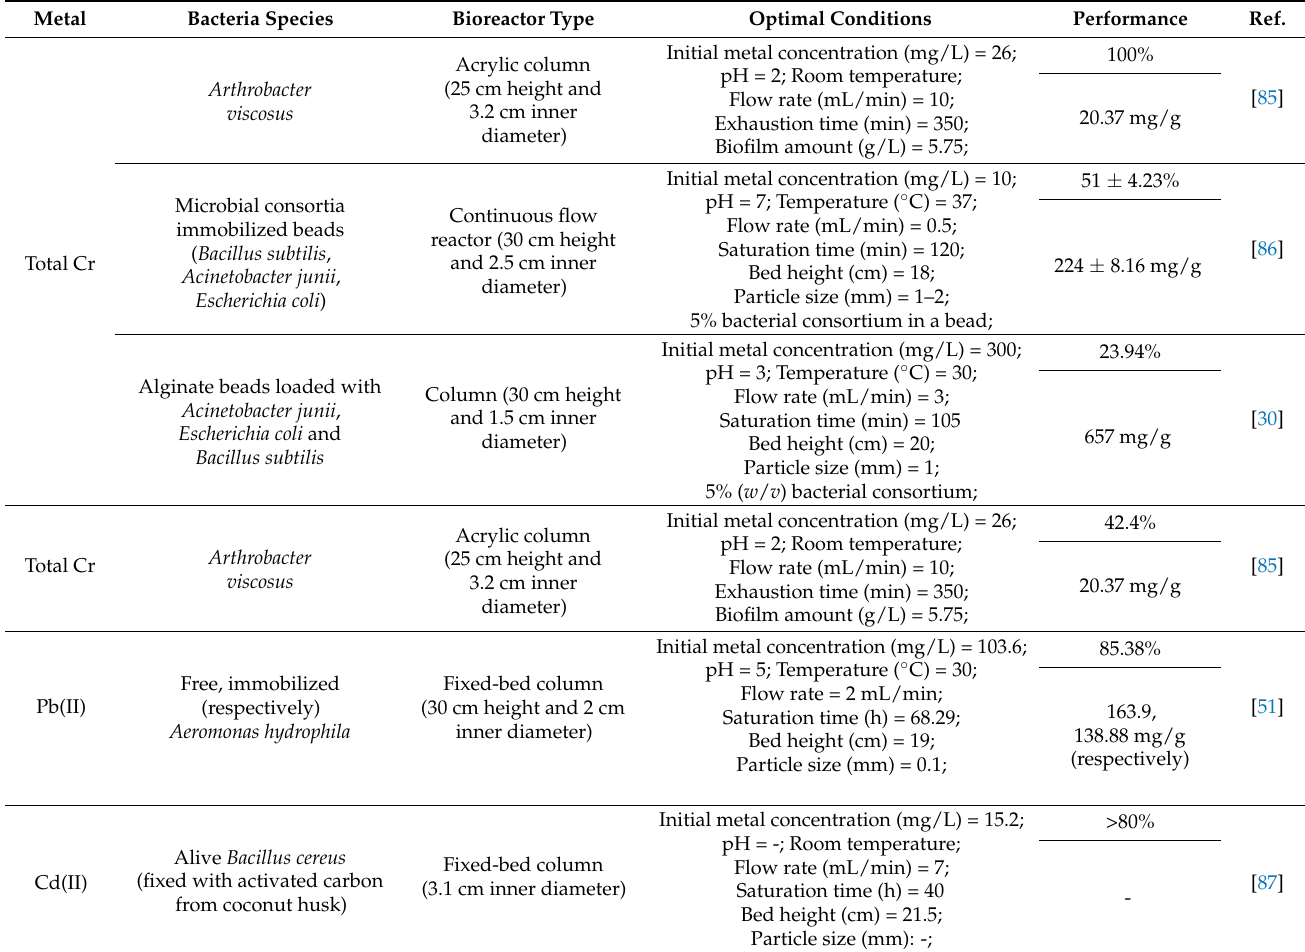
Table 3. Removal of heavy metals in a continuous system using bacterial biomass.